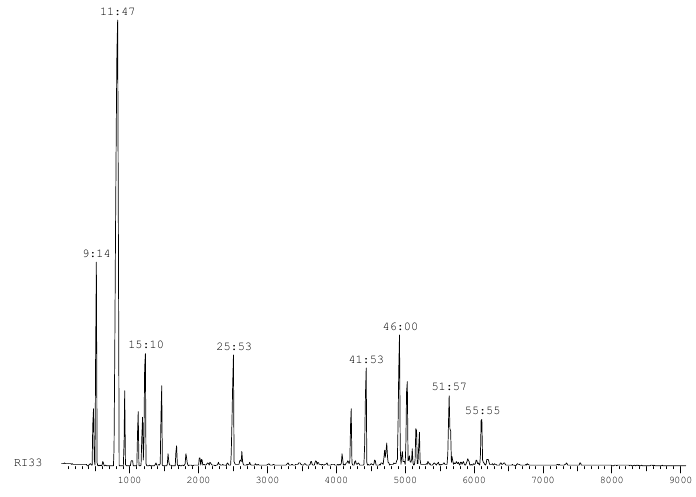
Figure 1. Chromatographic profile of S. molle .